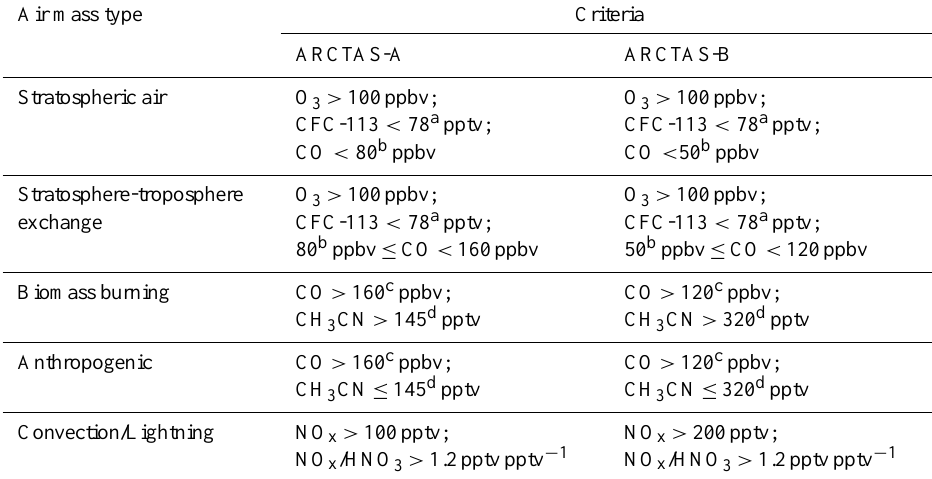
Table 2. Air mass characterization